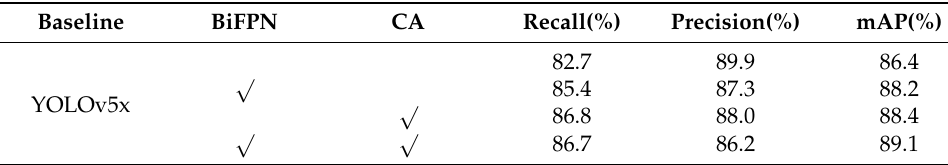
Table 6. Effect of each module on network performance.